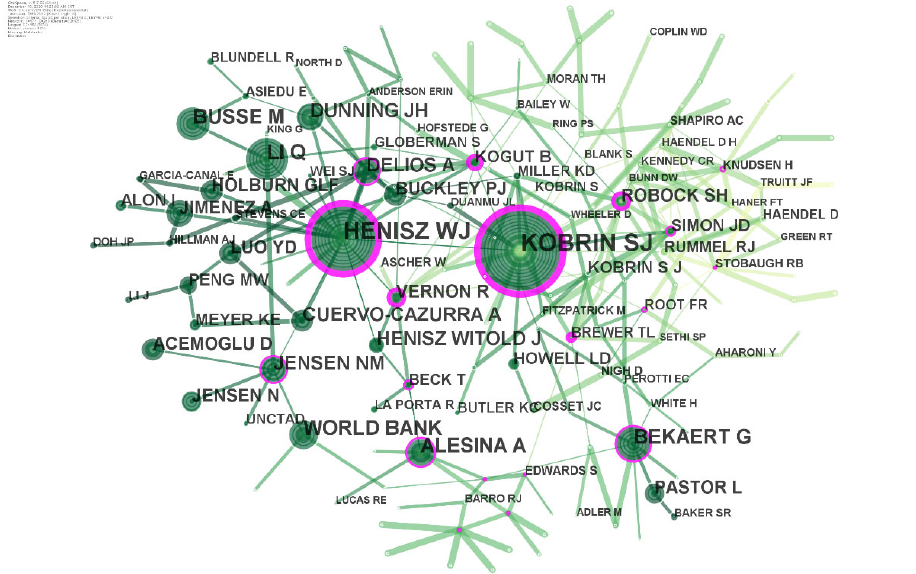
Fig . 7. Co-cited graph of authors of political risk related papers in WoS